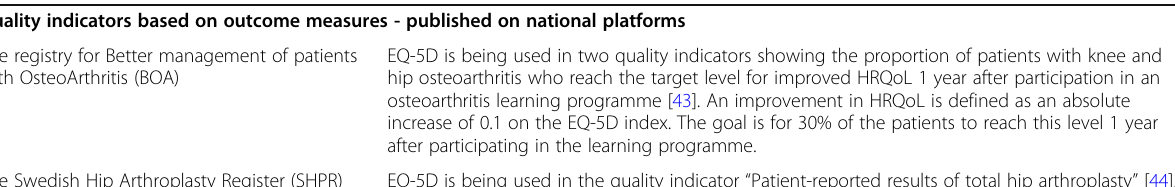
Table 3 Use of EQ-5D-data in quality indicators Registry Description of quality